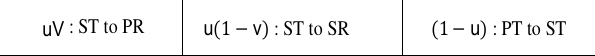
Fig. 2: Segmentation of phase